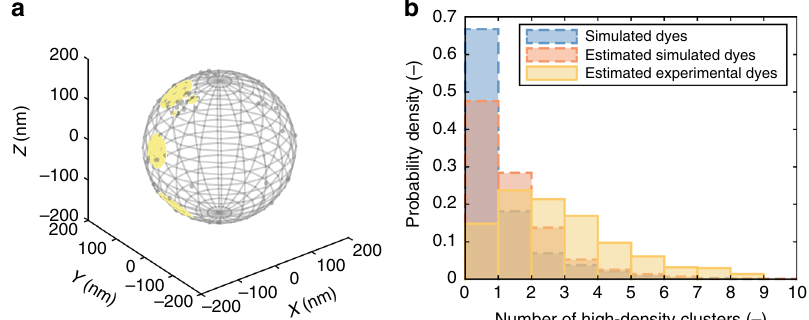
Fig. 6 Occurrence of regions with a high functional group density. a Identi fi cation of high-density regions on the surface of a nanoparticle. High-density regions (yellow circles) are de fi ned as containing the estimated locations of ≥ 5 fl uorophores (grey points) in a surface region with radius ≤ 50 nm. b Probability mass function of the number of high-density clusters on a nanoparticle. The plot depicts distributions for the (stochastically homogeneously) ¼ 937), the (stochastically homogeneously) simulated estimated fl uorophore locations (dashed simulated fl uorophore locations (dashed blue, N beads ; sim ¼ 937) and the experimentally observed nanoparticles (solid yellow, N ¼ red, N beads ; est beads ; exp